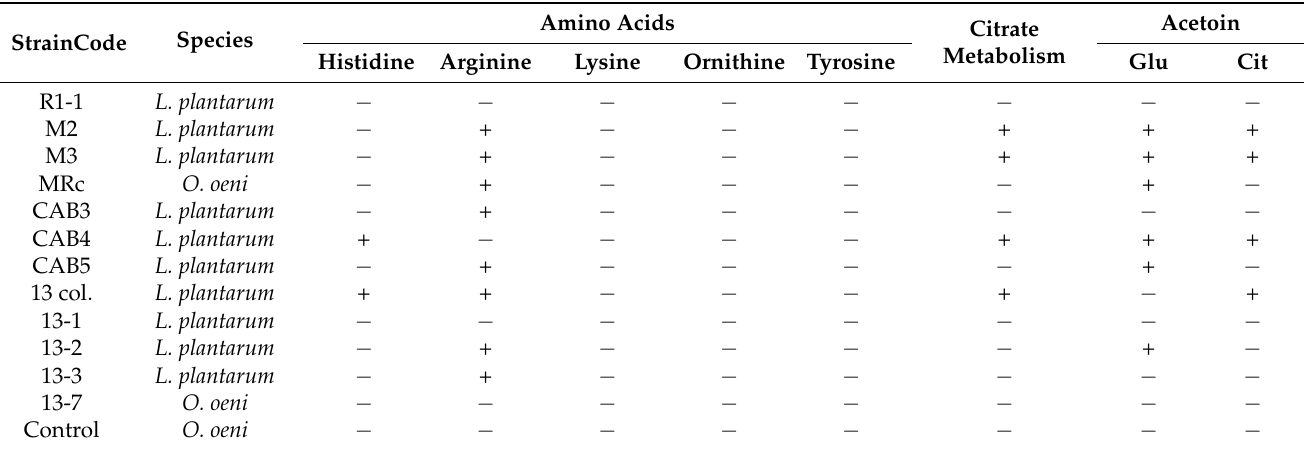
Table 2. α -amino acid decarboxylation capacity, citrate consumption, and acetoin production of the tested lactic acid bacteria